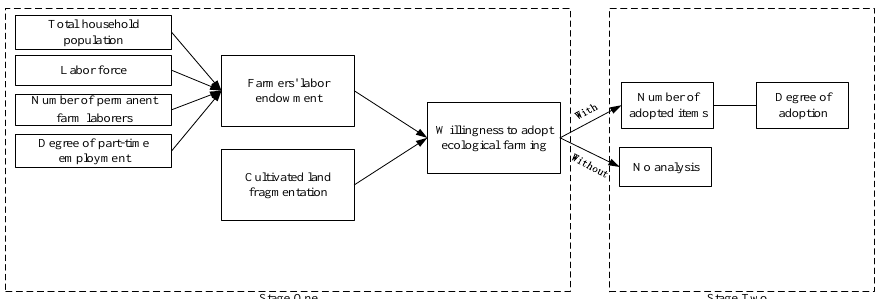
Figure 1. Ecological farming decision-making process.